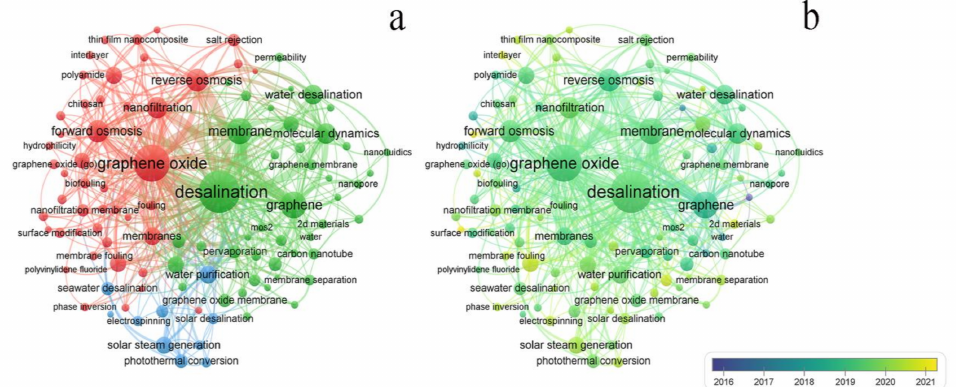
Figure 5. Density plot of author keywords: ( a ) network of author keywords; and ( b ) overlay graph of author keywords colored by the